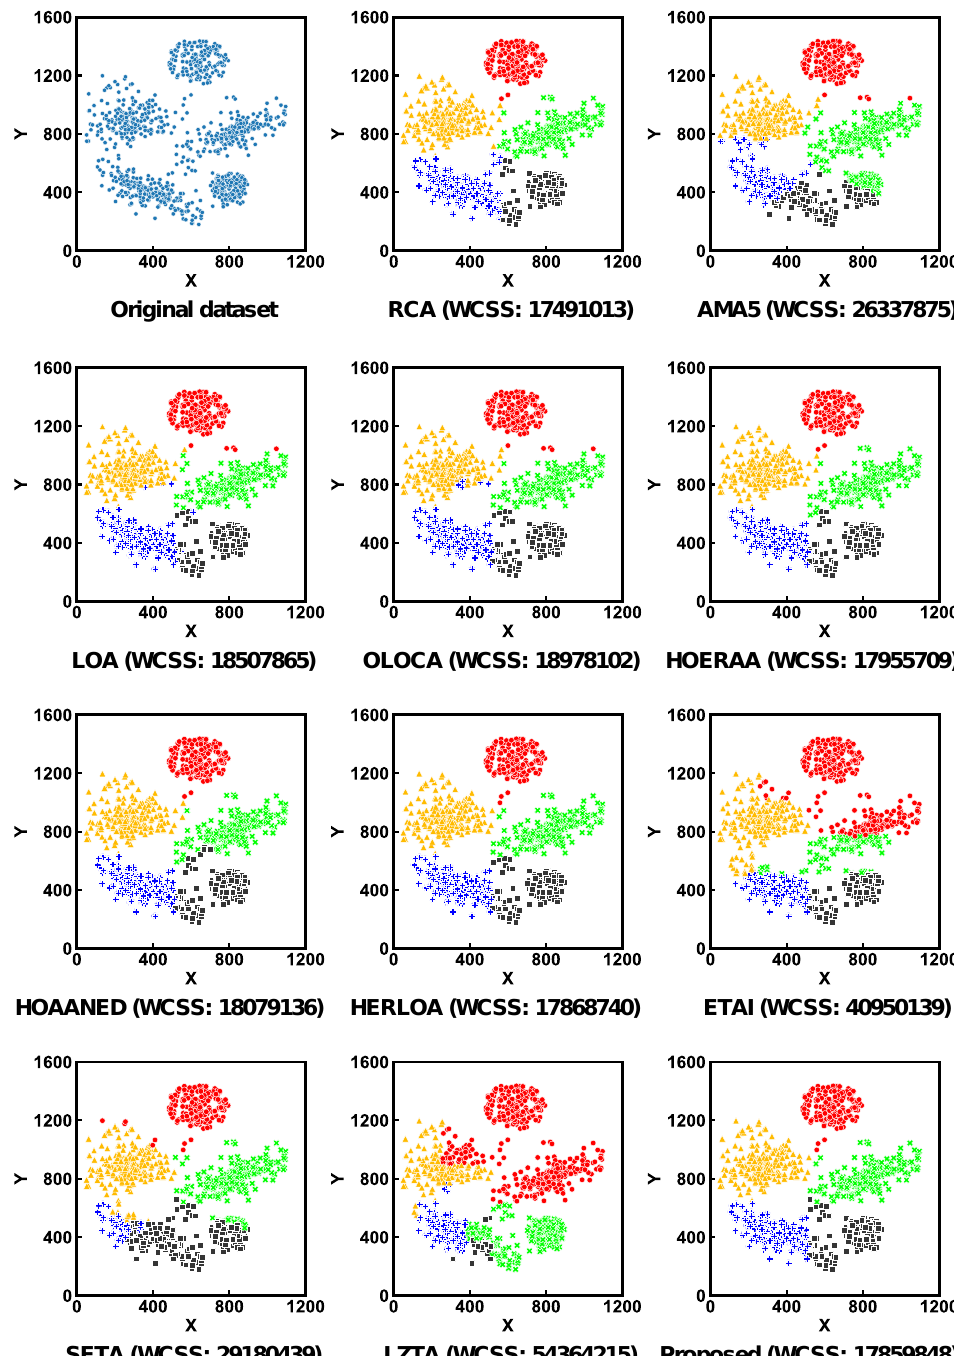
Figure 6. Original dataset and k -means clustering outputs produced using accurate and approxi- mate